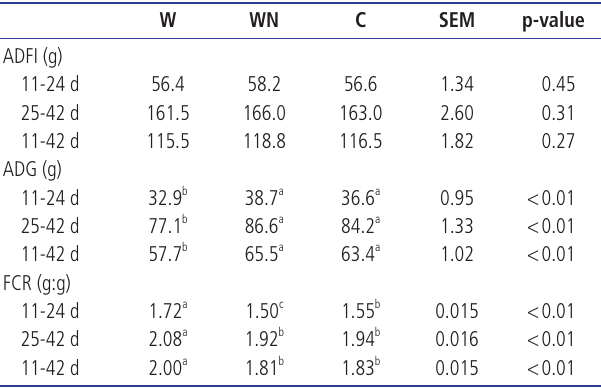
Table 2. Effect of Natuzyme Plus 1) inclusion in wheat-based diet on growth performance of broiler chickens from 11 to 42 d of age W